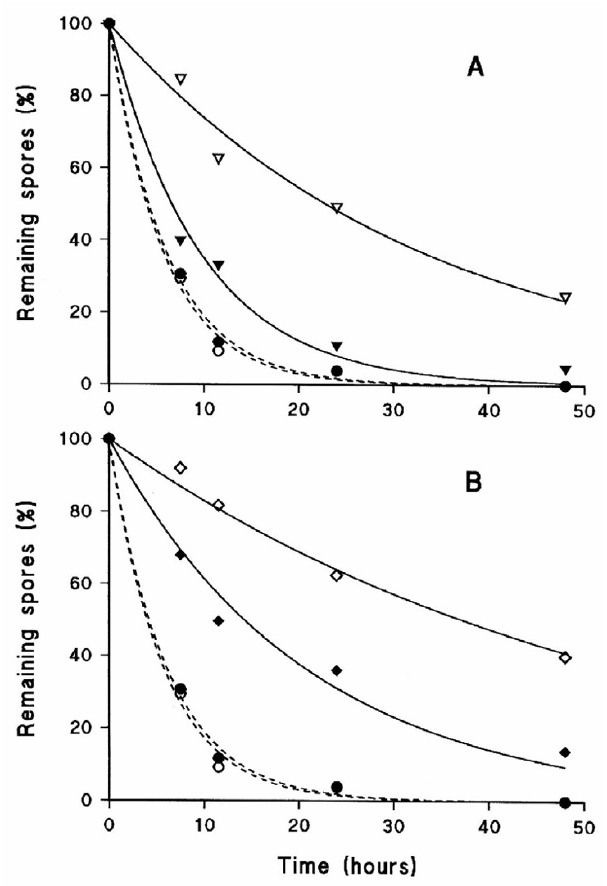
Figure 1 The effect of temperature (A) and osmotic pressure (B) on spore germination. Plc -null (closed symbols) and wild-type control (open symbols) spores were inoculated in growth medium at 22 ° C (circles) or 16 ° C (triangles), or in growth medium containing 0.2 M sucrose (diamonds). The time at which 50% of the spores were germinated was calcu- lated by exponential curve fitting using the program FigP. The data shown are from a typical experiment; the calculated ger- mination time for many different conditions are summarized in table 1.